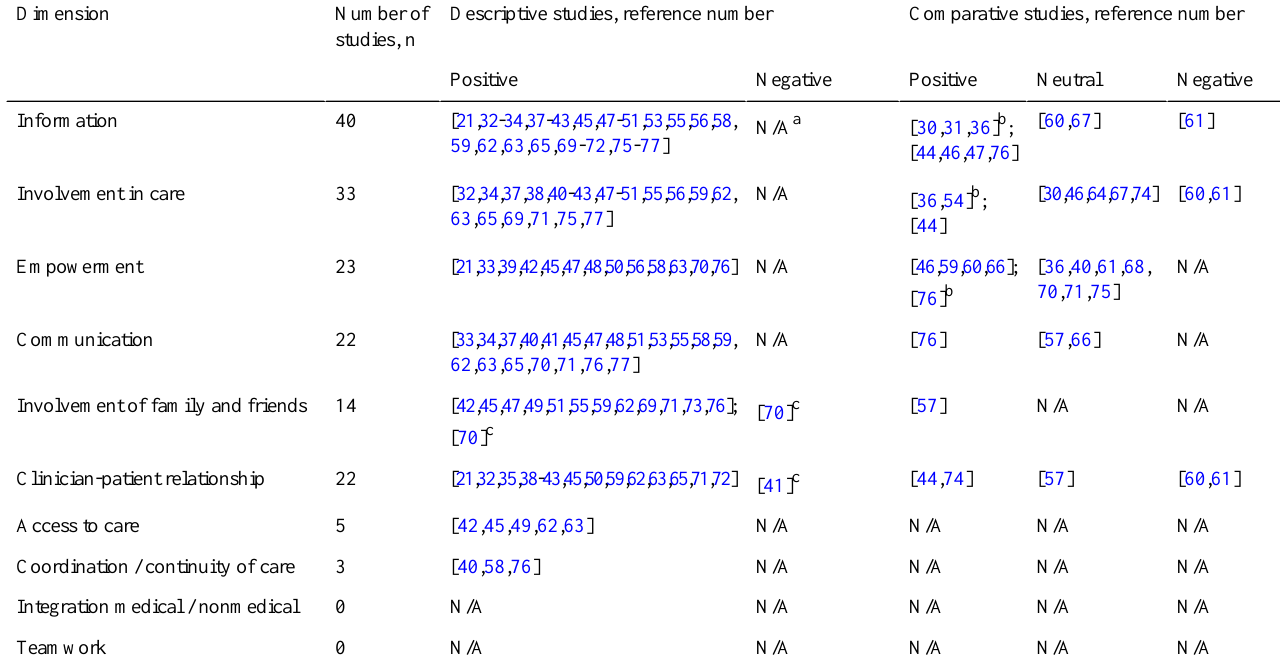
Table 2. Summary of results for dimensions of patient-centered care. This table represents, for every explored dimension of patient-centered care, whether reported outcomes point in a positive or negative direction. “Negative” in a pre-post comparative design means “less positive than expected.” In a pre-post or intervention-control design, the term “neutral” refers to the outcome “no difference” or “no significant difference.” Comparative studies, reference numberDescriptive studies, reference numberNumber of studies,